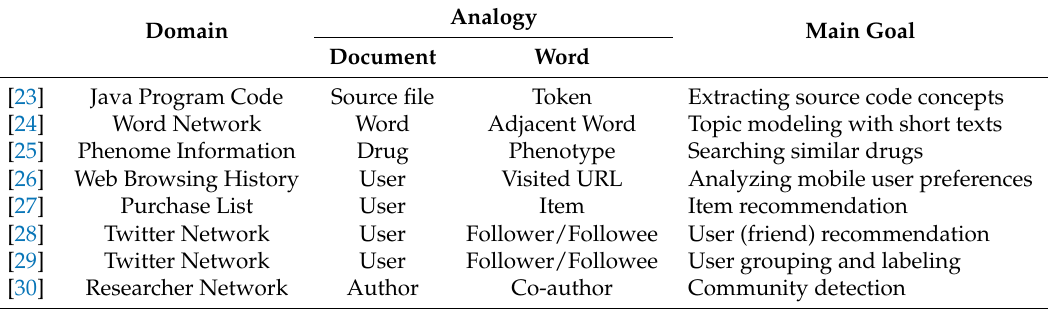
Table 1. Related work using analogies from latent Dirichlet allocation (LDA).